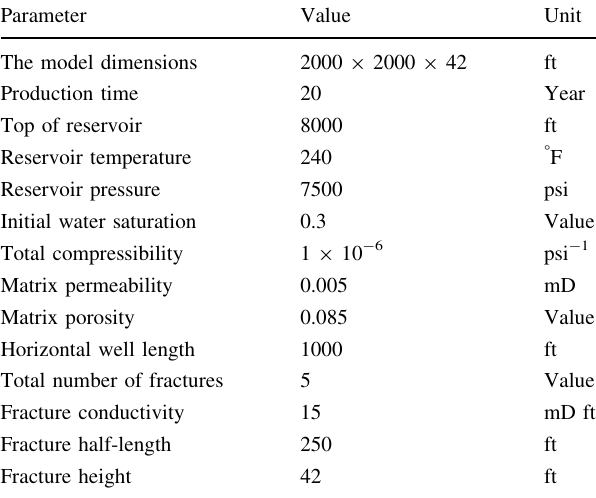
Table 2 Model input parameters for the base